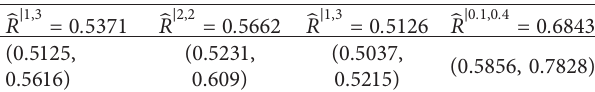
Table 4: 􏽢 R | a,b and its corresponding C.I for real datasets. 􏽢 R | 1 , 3 � 0 . 5371 􏽢 R | 2 , 2 � 0 .